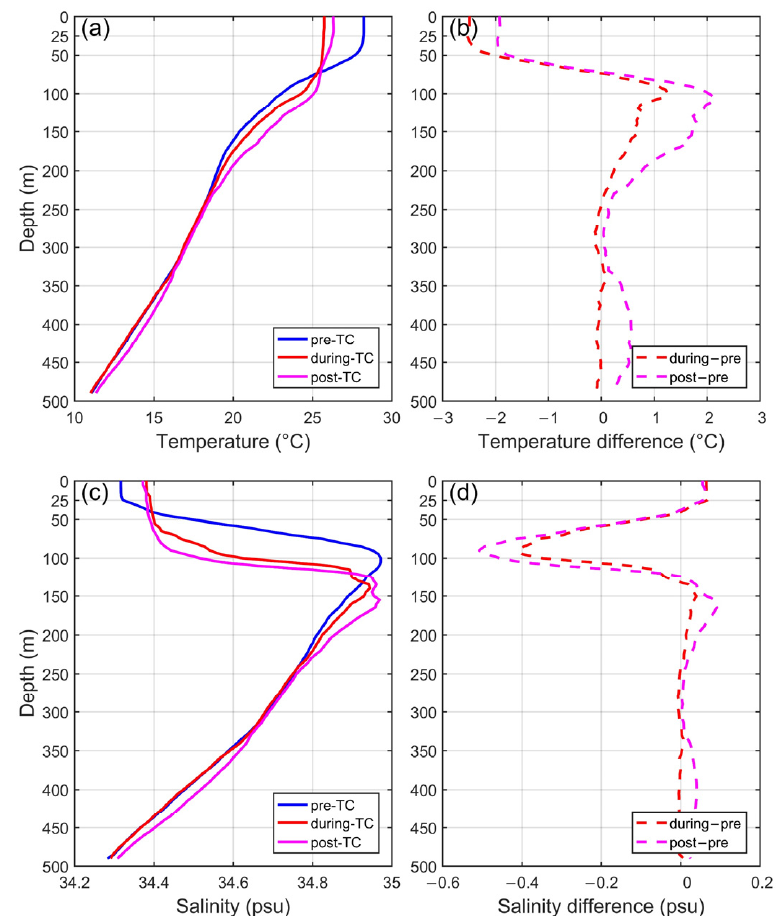
Figure 7. Temperature and salinity profiles measured by Argo Float 5901989 before, during, and after the passage of Prapiroon and their difference from the pre-typhoon profiles. ( a ) Temperature profiles; ( b ) temperature difference; ( c ) salinity profiles; and ( d ) salinity difference. The blue, red, and pink lines represent the average profiles before, during, and after Prapiroon’s passage, respectively. Red (pink) dotted lines indicate the difference between during-typhoon (post-typhoon) and pre-typhoon profiles.